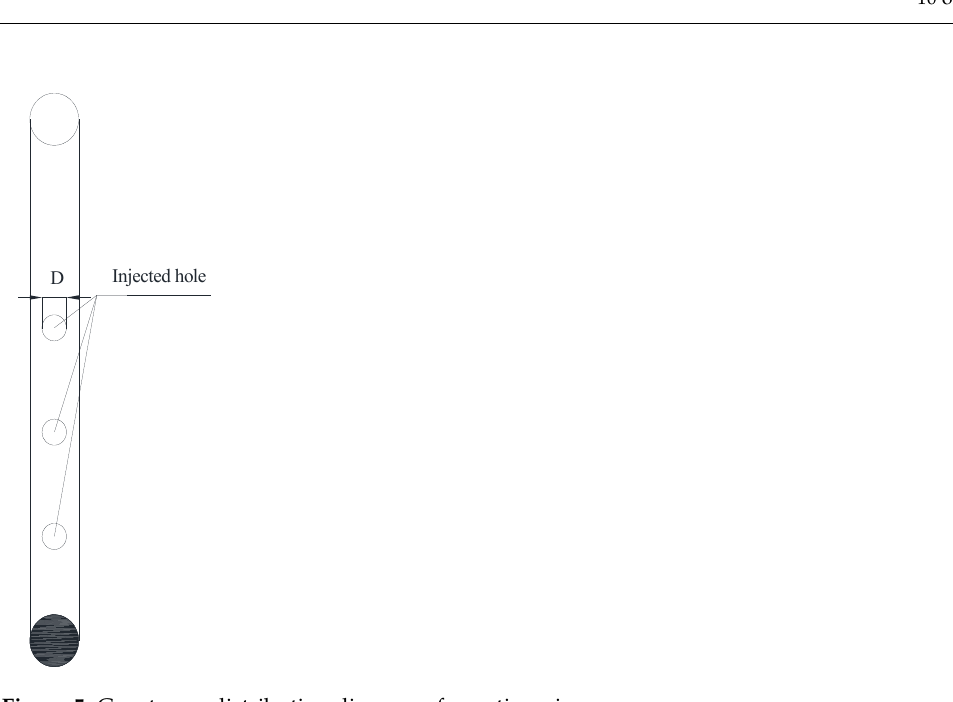
Figure 5. Grout pore distribution diagram of grouting pipe.